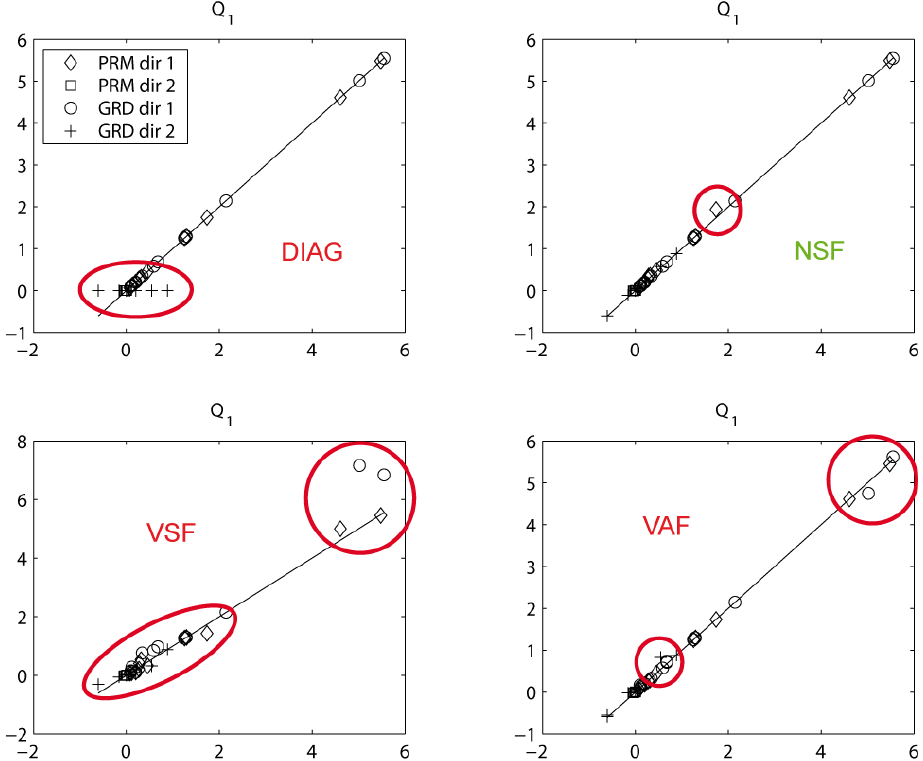
Figure 19. Comparison between the values of the microscopic total flux Q 1 calculated on the heterogeneous media (abscissa) with the total macroscopic flux computed with the same boundary conditions on the upscaled homogeneous medium (ordinate). Each graph represents all the numerical results for a given upscaling method (DIAG, NSF, VSF, VAF).